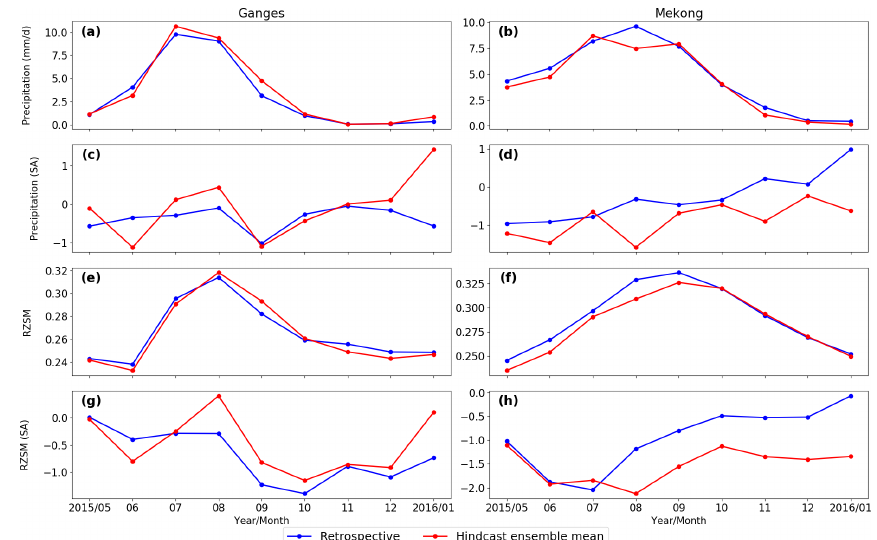
Figure 11. Comparison of monitoring and forecasting system on 2015–2016 drought event in Ganges basin (left panels) and Mekong basin (right panels) in terms of precipitation (a, b) , precipitation standardized anomaly (c, d) , root zone soil moisture (RZSM) (e, f) ; and RZSM standardized anomaly (g, h)